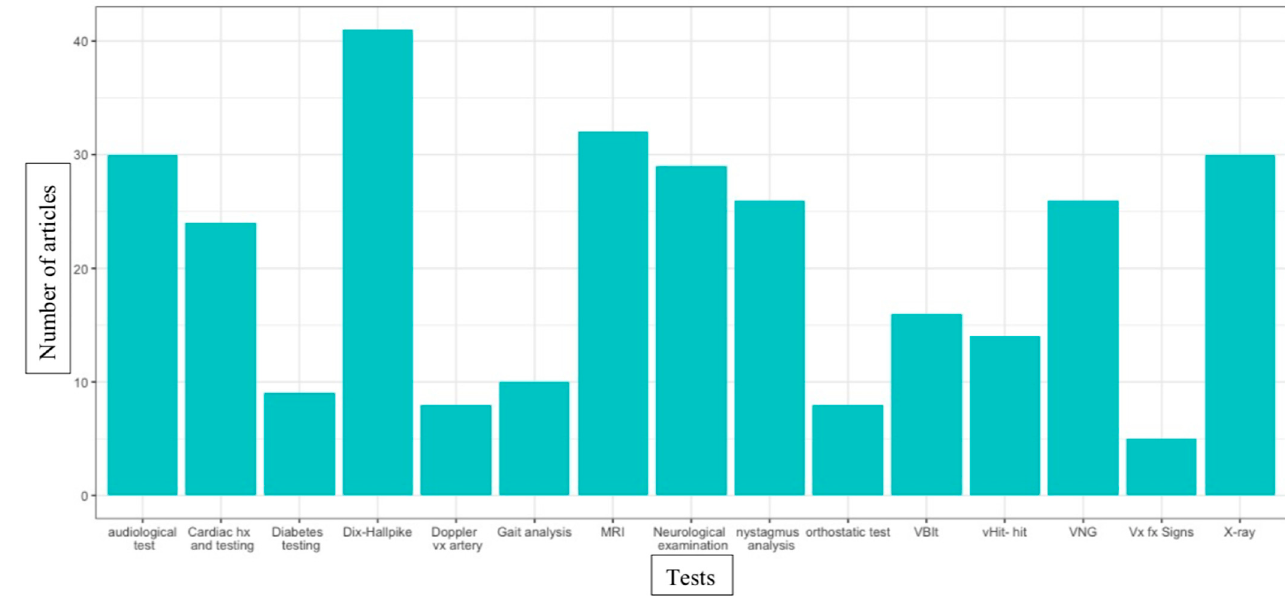
Figure 5. Pertinent tests for differential diagnosis. Cardiac hx: cardiac history, vx: vertebral, MRI: magnetic resonance imaging, VBIt: vertebrobasilar insufficiency testing, vHIT-hit: video head impulse test-head impulse test, VNG: videonystagmography, Vx Fx signs: vertebral fracture signs, X-ray: cervical spine X-ray